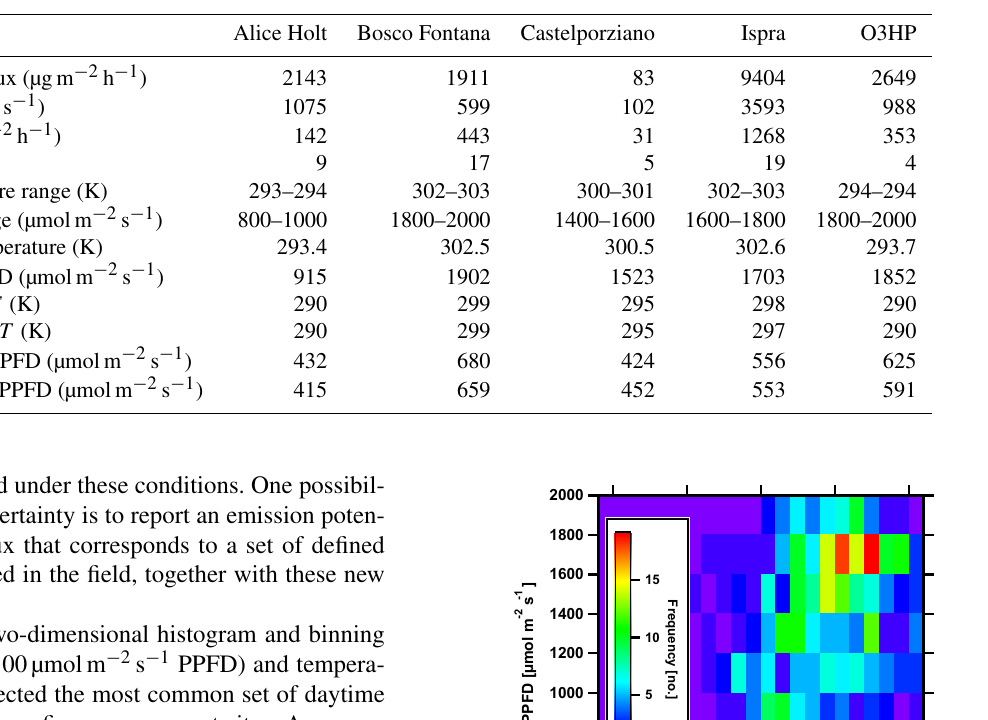
Table 4. Average isoprene emission fluxes at the Alice Holt, Bosco Fontana, Castelporziano, Ispra forest and O3HP sites under a set of defined conditions.